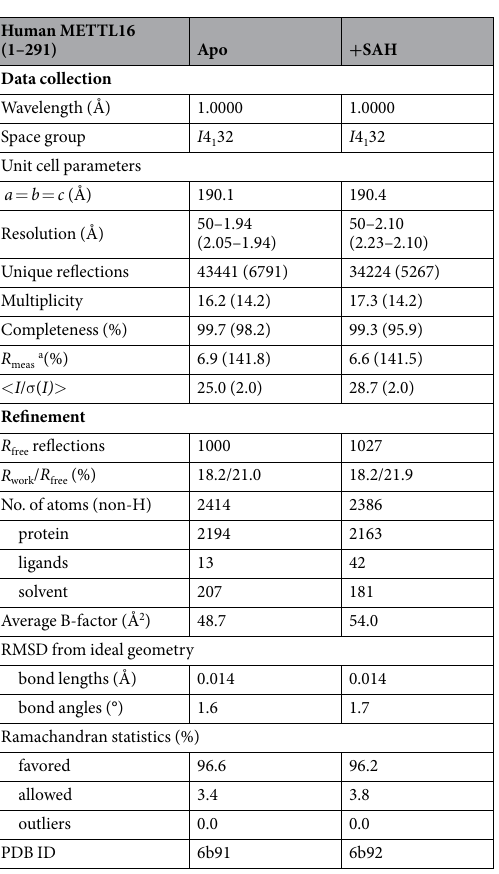
Table 1. Data collection and refinement statistics. a R meas = redundancy independent R-factor 70 . Values in parentheses correspond to the highest resolution